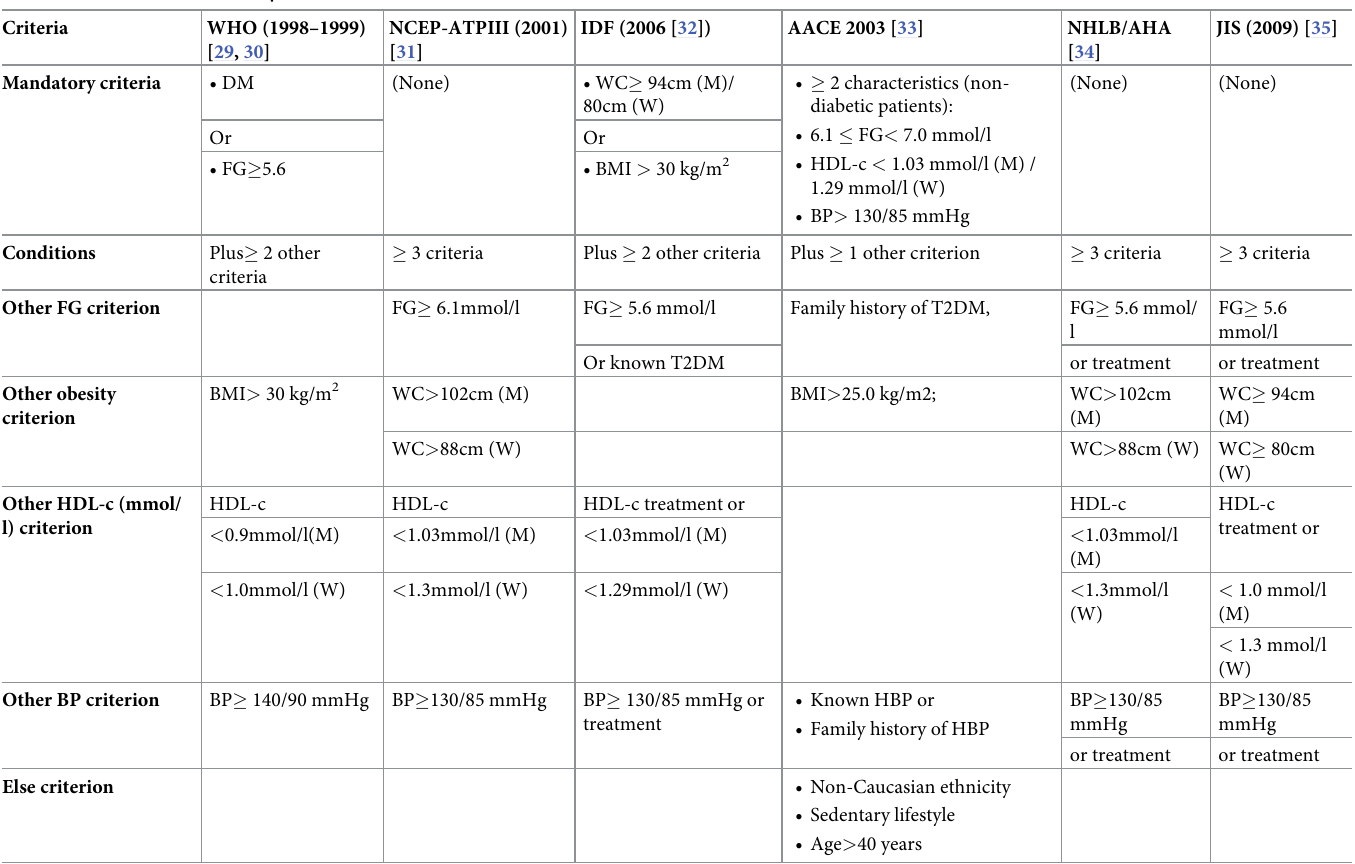
Table 1. Criteria for metabolic syndrome for each